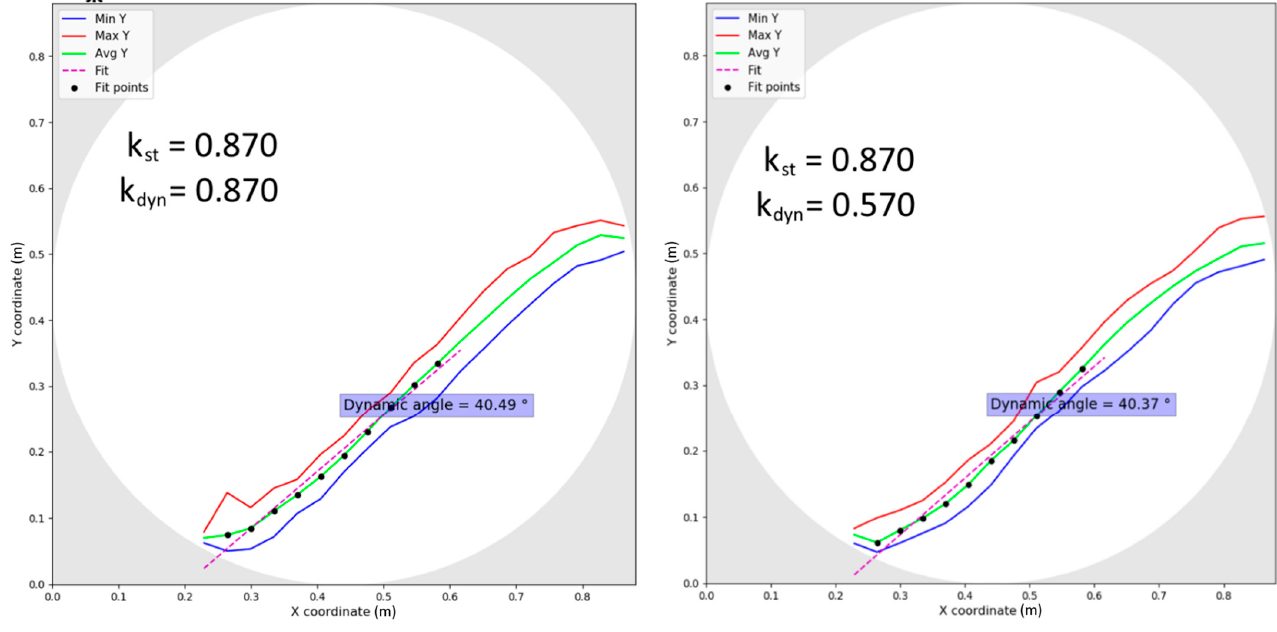
Figure 7. Friction coefficient “ore-steel” experiment conditions. ( a ) Simulated experiment, ( b ) Laboratory experiment.